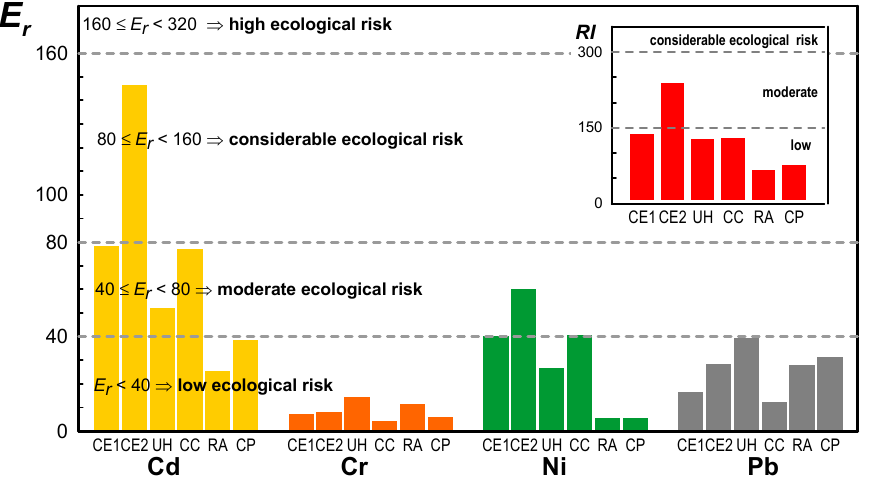
Figure 6. Values of the ecological risk factor ( E r ) and the global potential ecological risk ( RI ).